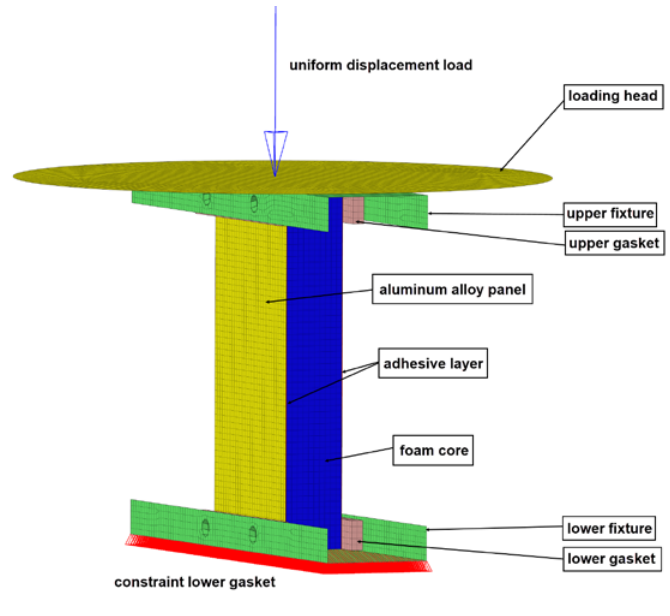
Figure 3. Finite element model of sandwich plate under edgewise compression load.